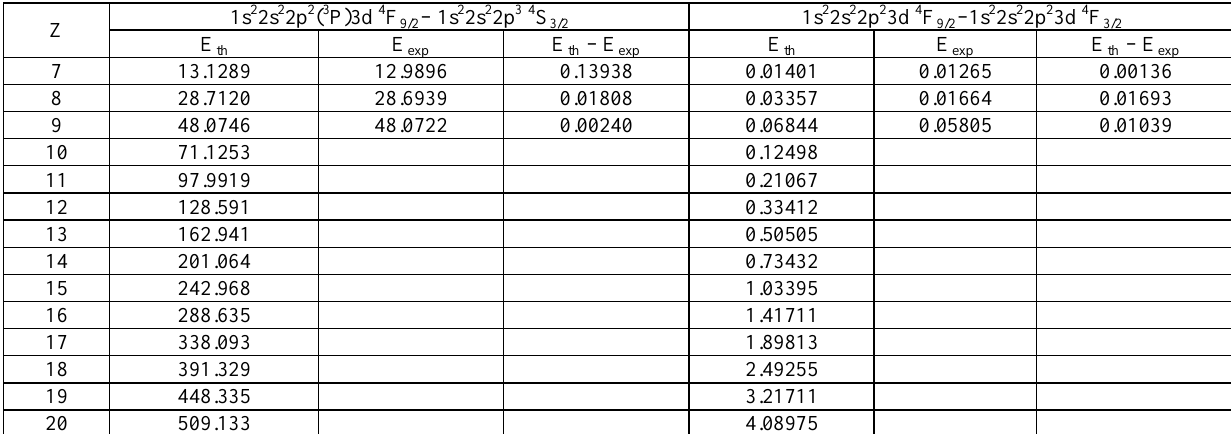
Table 8. Comparison of the calculated energies (in eV) of 1s 2 2s 2 2p 2 ( 3 P)3d 4 F 9/2 states of nitrogen-like ions and fine splitting